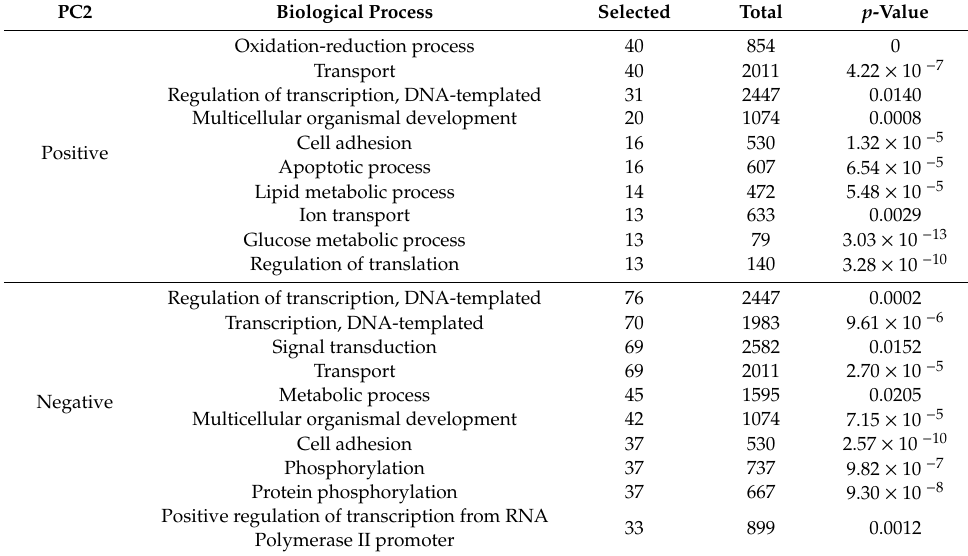
Figure 5. Principal component analysis of gene expression. Hippocampal samples were obtained from mice housed confrontationally for three days. Group-housed mice were kept in a cage for one month. The principal component (PC) ordination of ANOVA-positive genes us based on the transcriptome of hippocampal gene expression in mice of GC (open circle), GT (closed circle), CC (open square) and CT (closed square) groups ( n = 2 for each group). Each small dot represents the expression of each gene. Neuronal Per-Arnt-Sim (PAS) domain protein 4 (Npas4) is shown as a small black circle. Table 1. The e ff ect of theanine ingestion on the magnitude of gene expression on the PC2 axis.